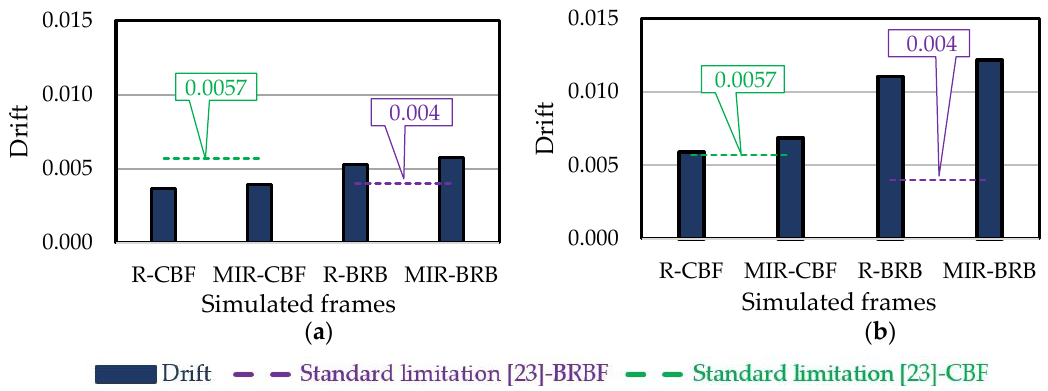
Figure 4. Average drift comparison of ( a ) 10-story frames and ( b ) 15-story frames.